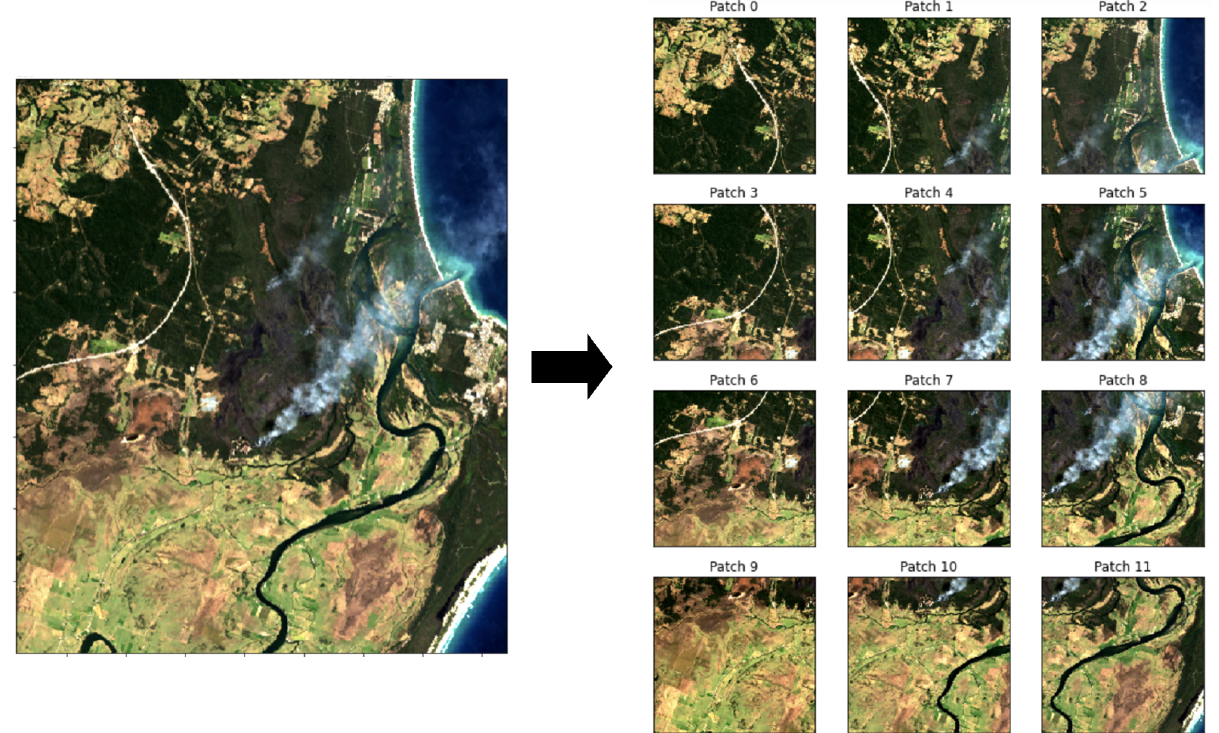
Figure 3. Overlapped